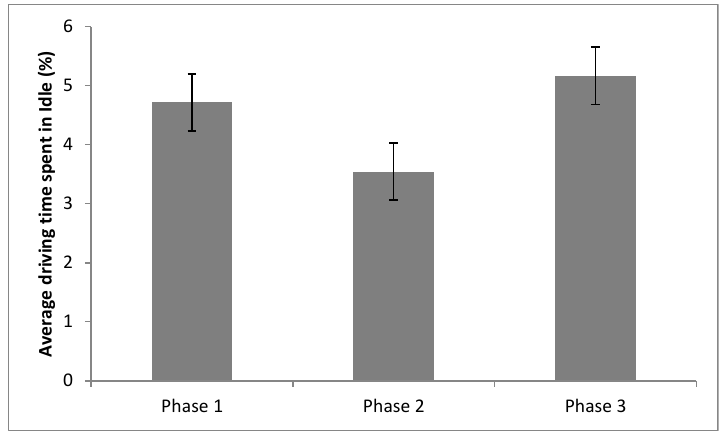
Figure 5. Average percentage of driving time in Idle.